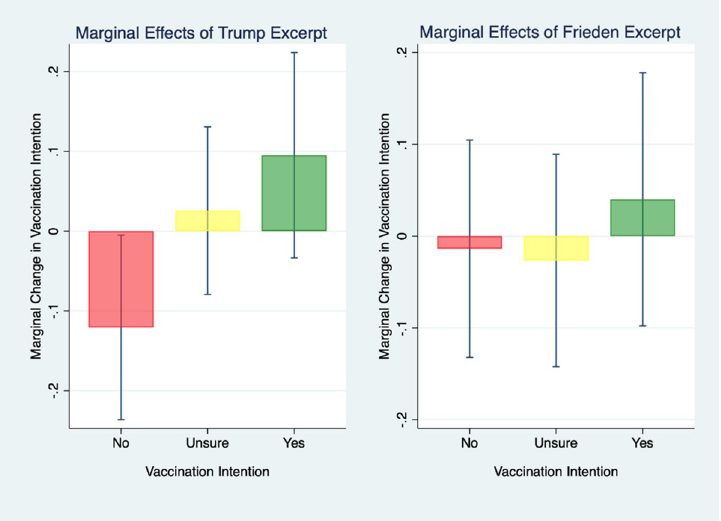
Fig 2. Marginal effects on vaccination intention compared to control group by experimental condition, with 95% confidence